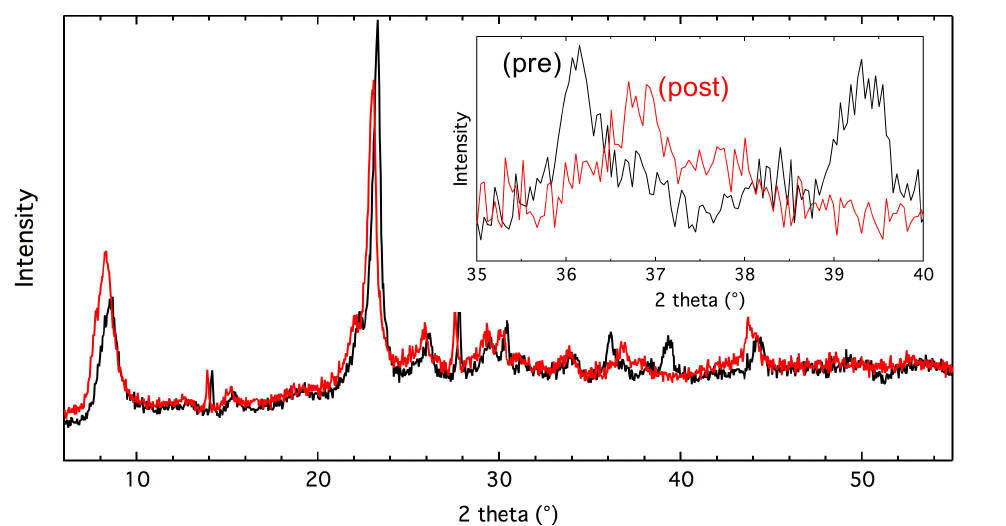
Figure 1. X-ray diffractogram for the (2% Cu + 2% Fe)-beta sample before (pre) and after (post) the reactive solid-state ion-exchange with [NH 3 +NO] showing disappearing reflections characteristic for CuO, after the [NH 3